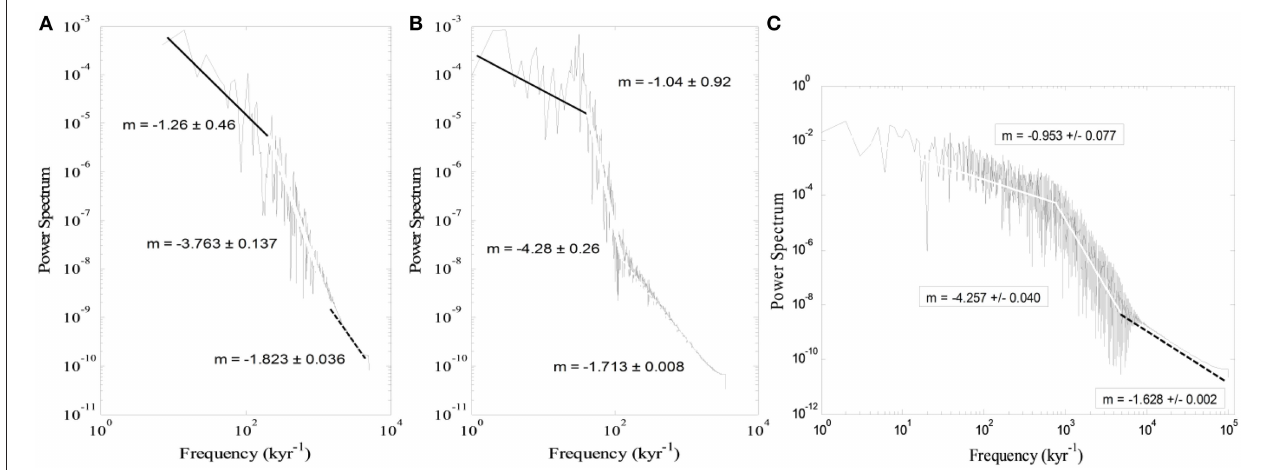
FIGURE 6 | Comparison between the PSD of the time series of: (A) the SHA.DIF.14K model, (B) the LCS model, (C) the IL model with 15 disks.